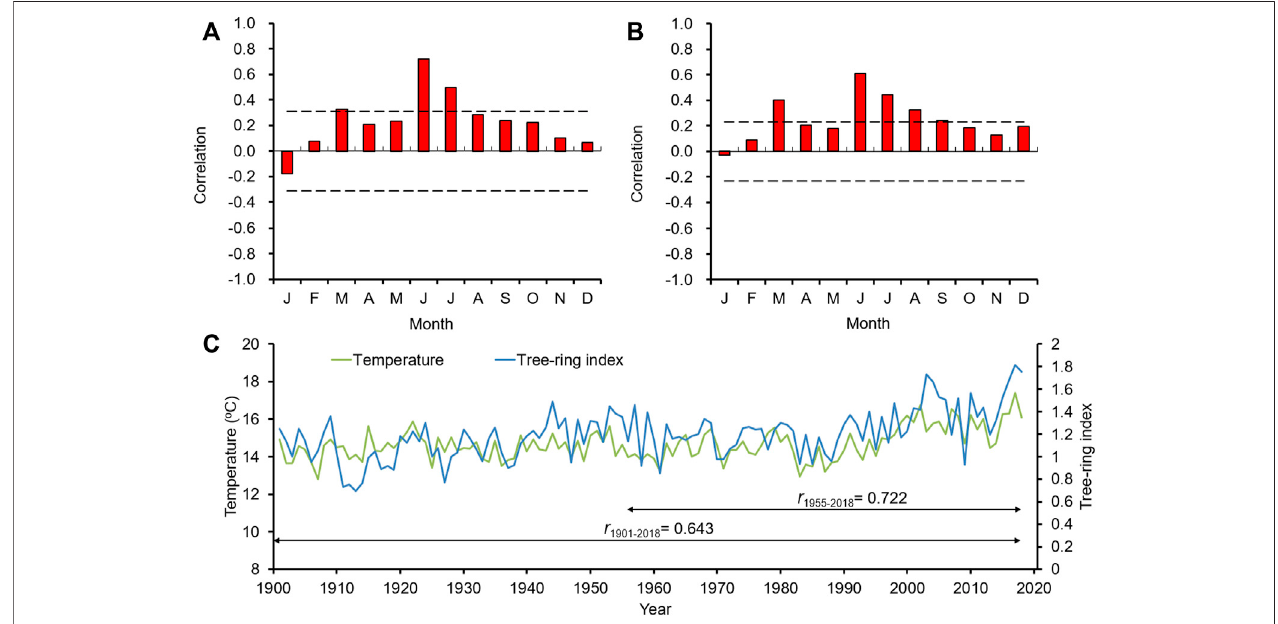
FIGURE 3 | Simple correlations of the composite chronology with the monthly CRU mean temperature (A) (1955 – 2018; (B) (1901 – 2018) from January to current December. The dash lines indicate signi fi cant variables ( p < 0.01). (C) CRU mean June – July temperature and the composite chronology during their common period 1901 – 2018.